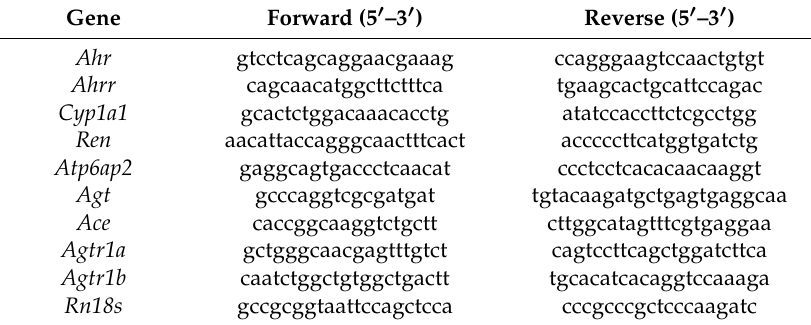
Table 3. PCR Primer